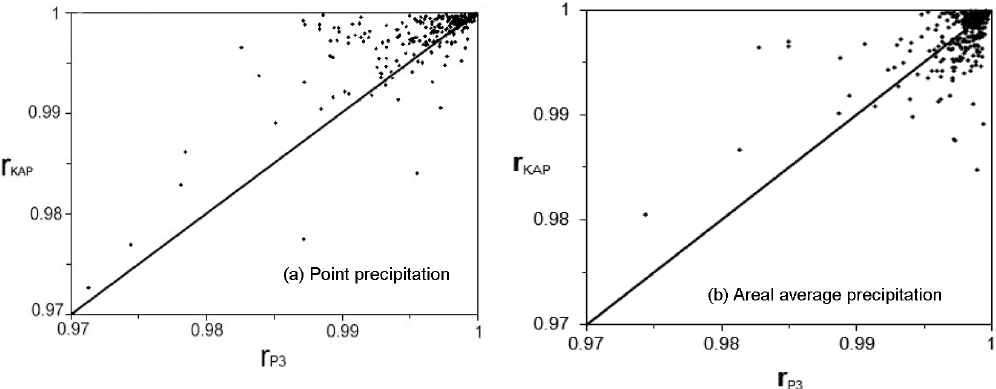
Figure 8. Comparison of r values for P3 (horizontal axis) and KAP (vertical axis) distributions for the (a) point and (b) areal average precipitation depths’ wet-day